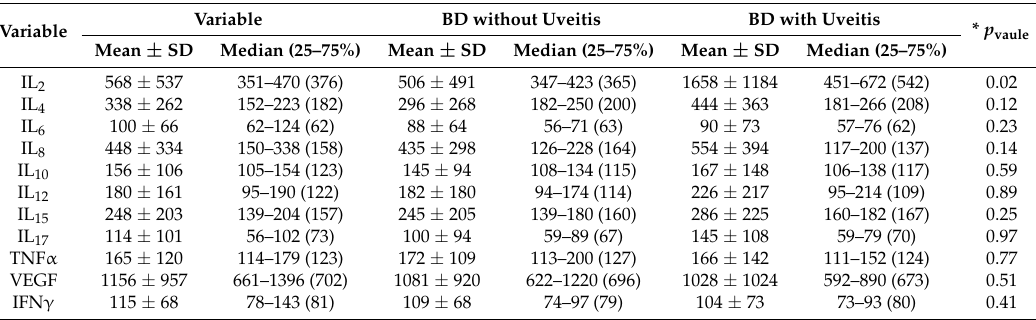
Table 2. Levels of cytokines in venous blood samples of enrolled cases ( µ